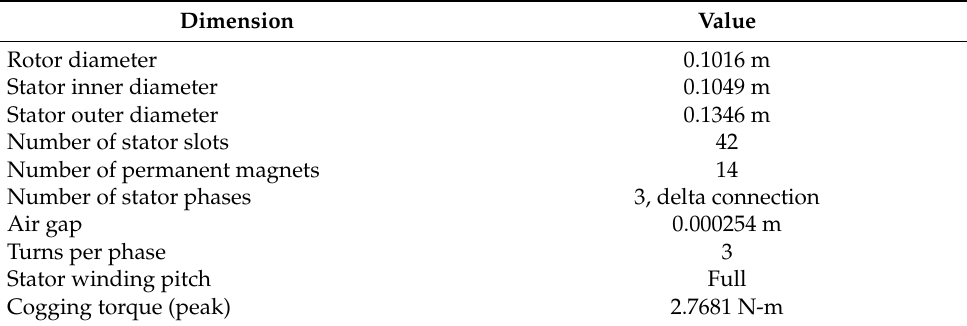
Table 1. Physical parameters of the three-phase permanent magnet generator demonstration.